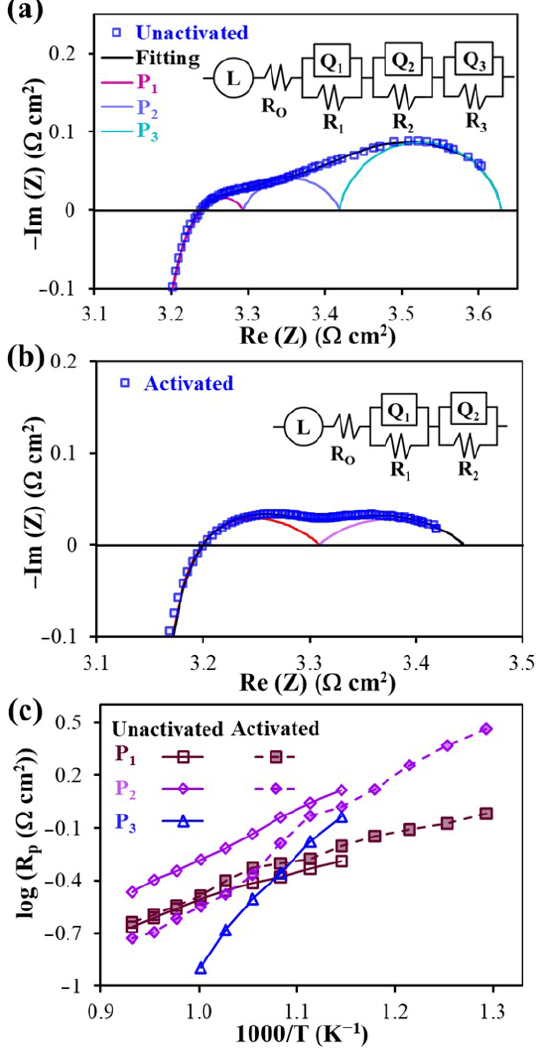
Figure 6. Equivalent diagrams and an example of fitting of BCZYF0.6 electrode before ( a ) and after ( b ) electroactivation and polarization conductivities ( c ), electrode processes of BCZYF0.6 (not shaded), and BCZYF0.6_Pr samples (shaded markers).